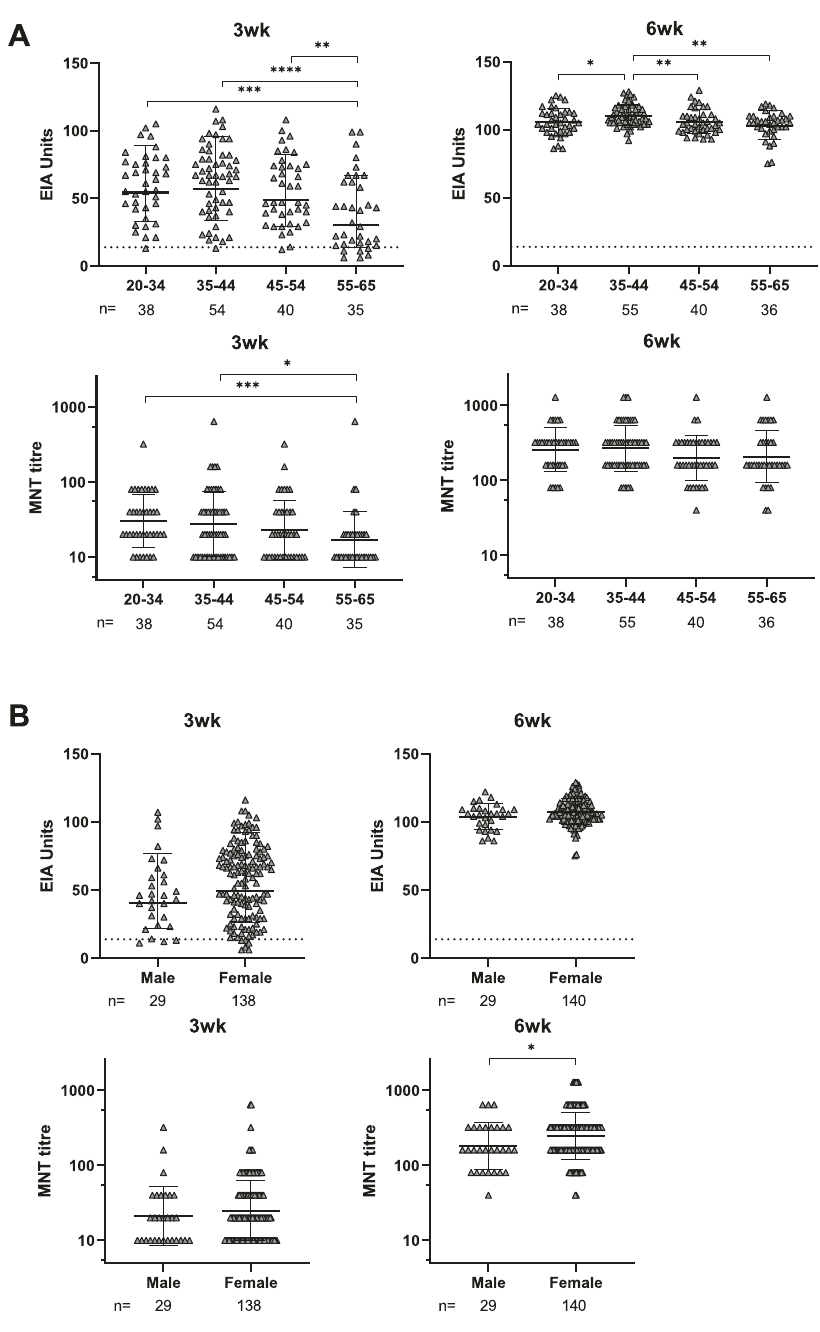
Fig. 5 Antibody responses against SARS-CoV-2 S1 protein and neutralization of FIN-25 by age and gender. A BNT162b2 vaccinated health care workers (initially seronegative, n = 169) were divided into four age groups. Age speci fi c differences of anti-S1 IgG antibody levels and neutralization titres against FIN-25 virus isolate were analyzed. Sera was collected three weeks (3w) and six weeks (6wk) after the fi rst vaccine dose. Differences between age groups were tested with two-tailed Mann – Whitney U test. Two-tailed p -values < 0.05 were considered signi fi cant. Exact p -values were ** = 0.0078, *** = 0.0007, and ****<0.0001 for 3wk EIA, ** = 0.0021 (age group 35 – 44 vs. 55 – 65), * = 0.0.231, and ** = 0.0041 for 6wk EIA, and * = 0.0133 and *** = 0.0005 for 3wk MNT. B Gender-speci fi c differences in S1 speci fi c IgG antibody responses and neutralization titres against FIN-25 were analyzed. Differences between age and gender groups were tested with two-tailed Mann – Whitney U test. Two-tailed p -values <0.05were considered signi fi cant. Exact p -values were * = 0.0412. The data in A and B are presented as geometric means and geometric SDs. Neutralization titres <20 were plotted as